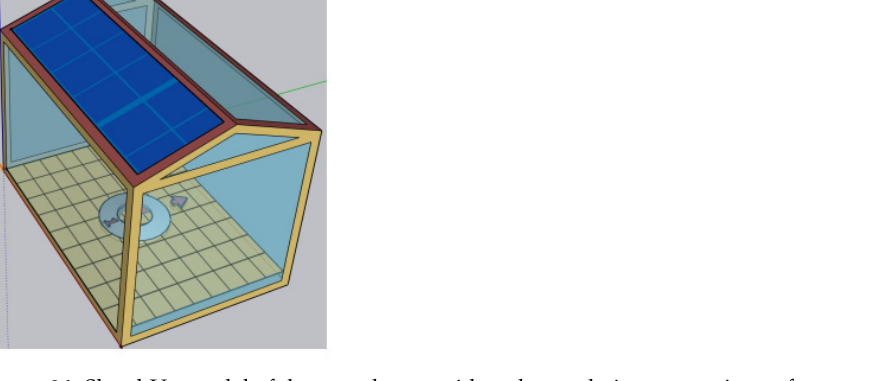
Figure 34. SketchUp model of the greenhouse with a photovoltaic array on its roof.